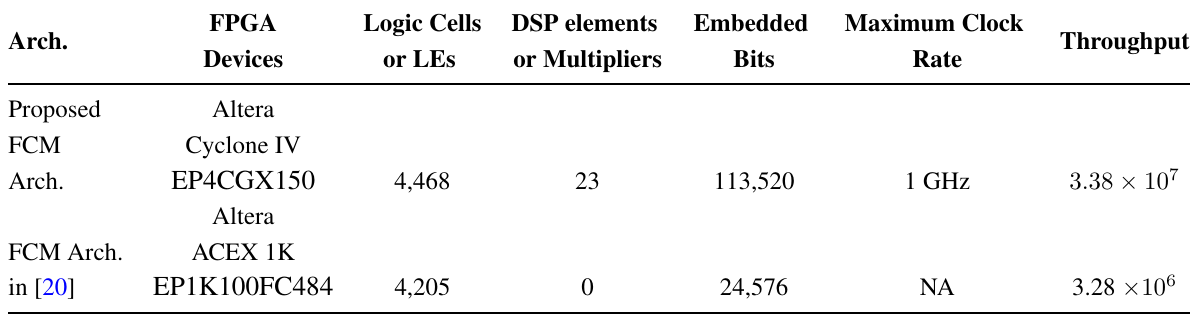
Table 11. Comparisons of the proposed FCM circuit with other FPGA-based clustering implementations. Arch. Proposed Altera Cyclone